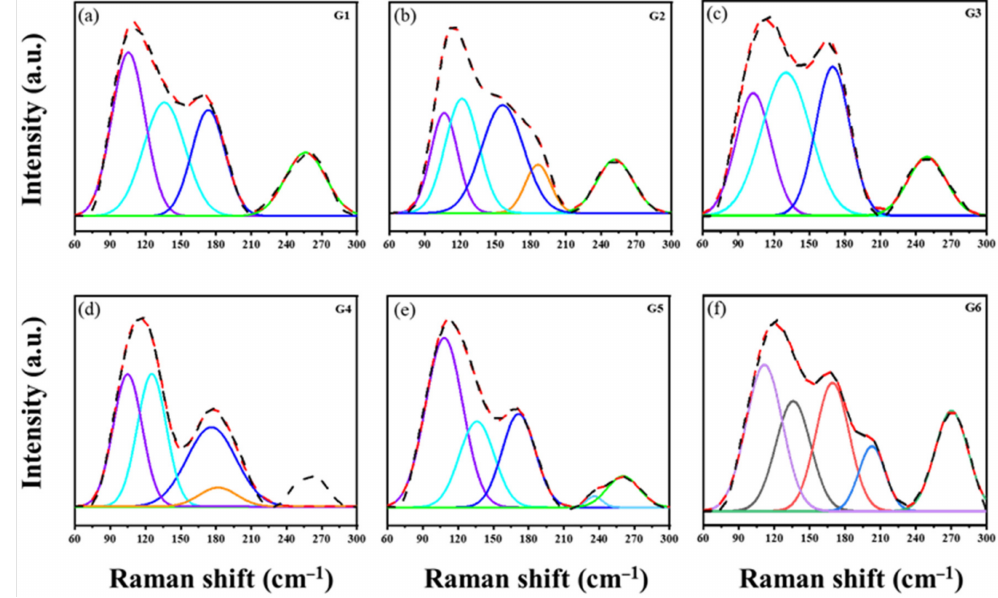
Figure 4. Raman spectra of ( a ) Ge 17.2 As 17.2 Se 10.5 Te 55.1 ; ( b ) Ge 17.2 As 17.2 Se 12 Te 53.6 ; ( c ) Ge 17.2 As 17.2 Se 13 Te 52.6 ; ( d ) Ge 17.2 As 17.2 Se 14 Te 51.6 ; ( e ) Ge 17.2 As 17.2 Se 14.5 Te 51.1 and ( f ) Ge 17.2 As 17.2 Se 16 Te 49.6 .